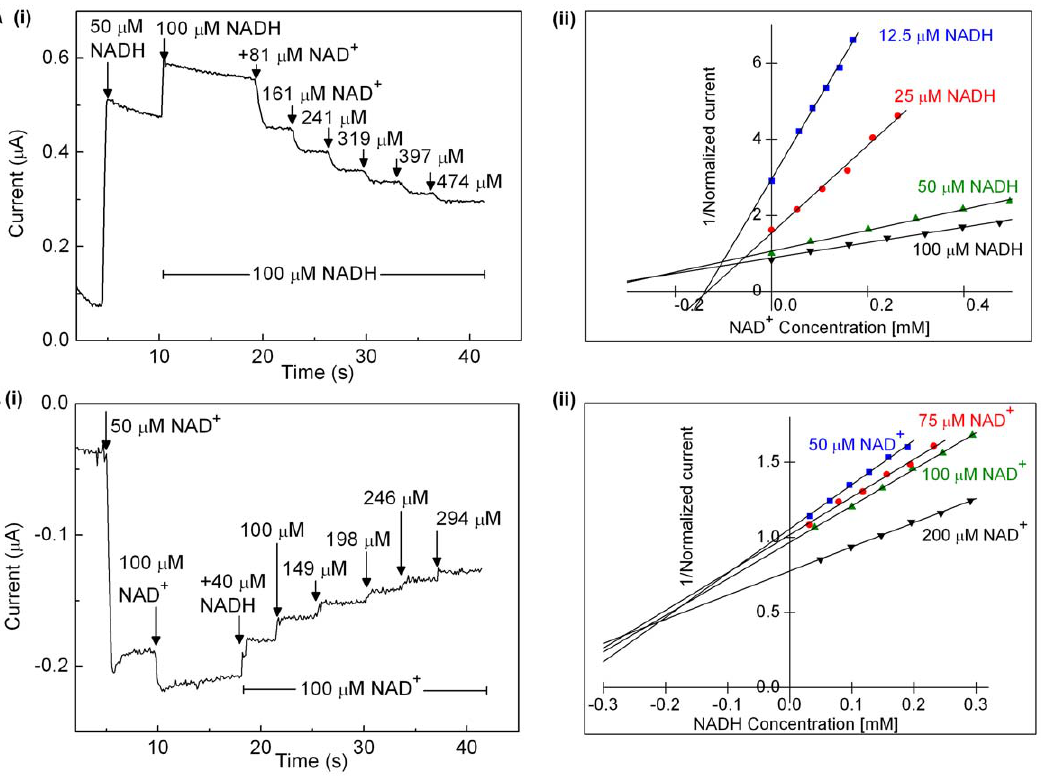
Figure 6. Demonstration of product inhibition of HoxFU. Raw data for experiments examining NADH oxidation at 2 62 mV (A) and NAD + reduction at 2 412 mV (B) are shown in plot (i) in each case. The substrate concentration was zero at the start of each experiment, and 50 m M substrate was then injected as indicated to provide a control step for normalization of the catalytic activity of each film. The substrate concentration was then adjusted to x m M (by dilution or addition as required. In the experiments shown in panels labelled (i), x=100. Aliquots of the inhibitor were then injected from a stock solution containing x m M substrate in order to keep the substrate level at x m M throughout the remainder of the experiment. Panels labelled (ii) show Dixon plots presenting data from a series of such experiments. Experiments were performed at 30 u C, electrode rotation rate: 2500 rpm.